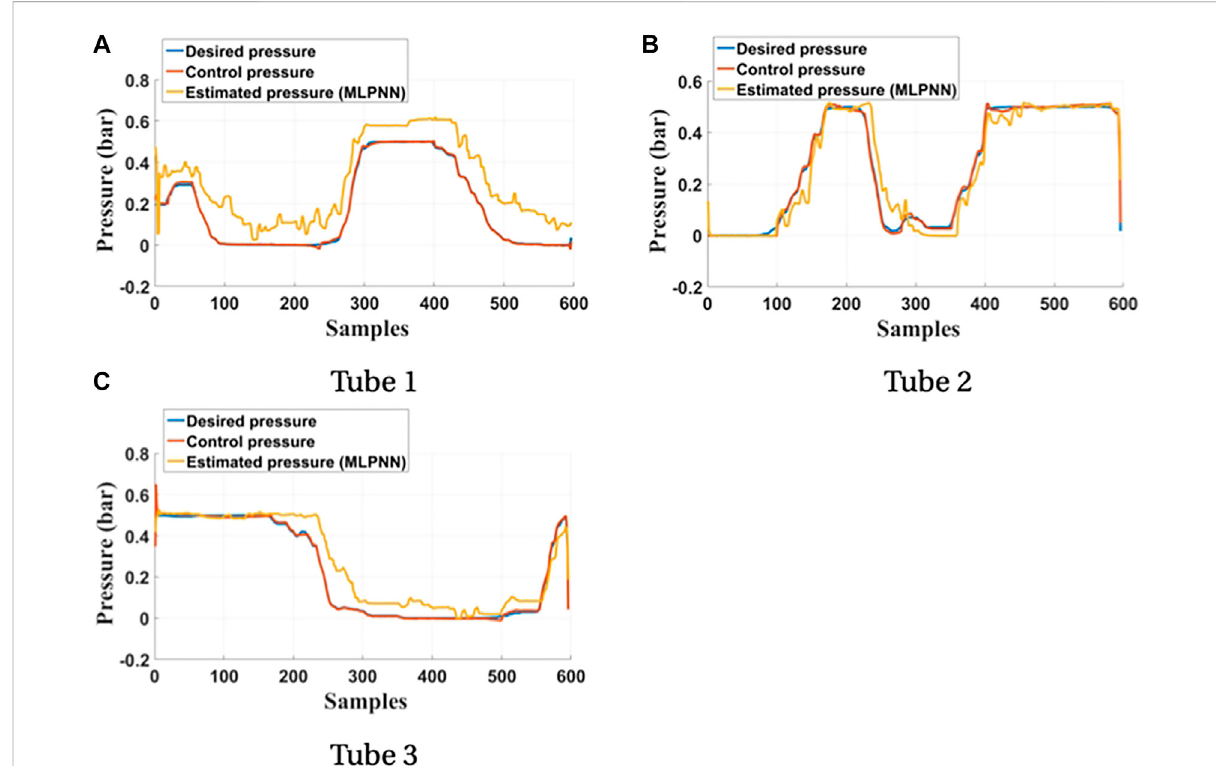
FIGURE 12 Comparison between the desired pressures and the predicted pressures of the three bending tubes. (A) Tube 1. (B) Tube 2. (C) Tube